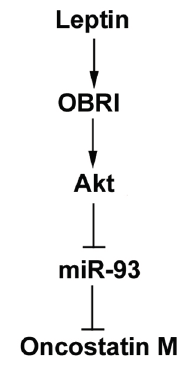
Figure 6. Schema of signaling pathways involved in leptin-induced OSM expression in osteoblasts. Leptin enhances OSM production in human osteoblasts by inhibition miR-93 expression through the Akt signaling